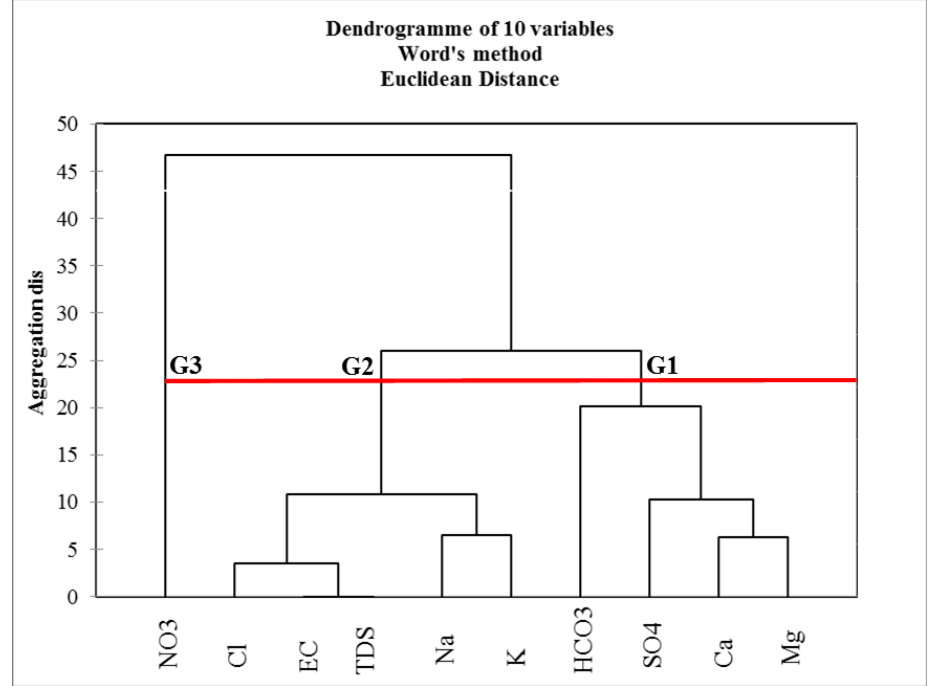
Figure 6. Cluster dendrogram for variables: G1 (group 1), G2 (group 2), G3 (group 3) and the groups could be distinguished in terms of their hydrochemical variable at the red line.